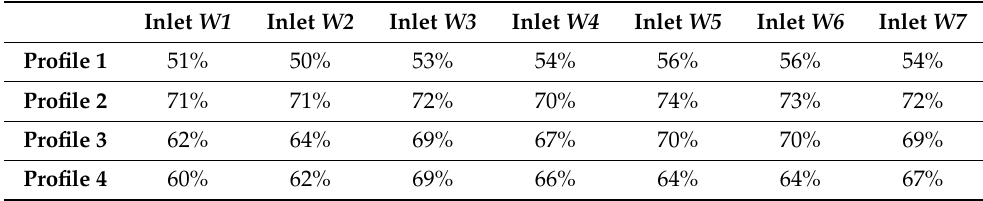
Table 4. Energy efficiency of the